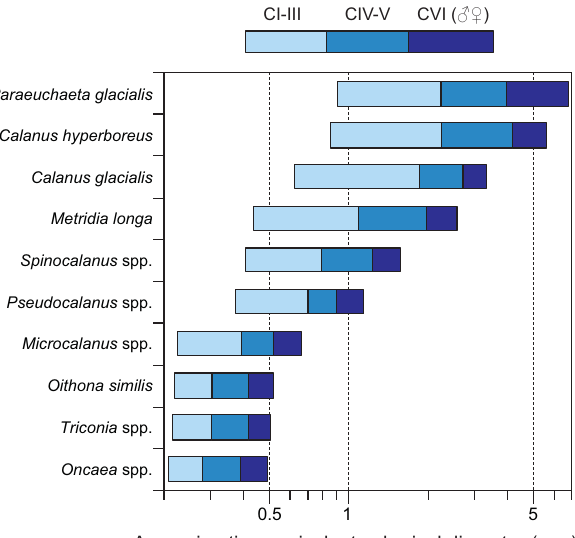
Fig. 8. Approximative equivalent spherical diameter (ESD) of each dominant copepod species (Fig. 7) as estimated with morphome- tric relationships. The apparent ESDs presented here should be regarded as maximum values, as they correspond to the elliptical biovolume (EBv, see Sect. 2.3 for